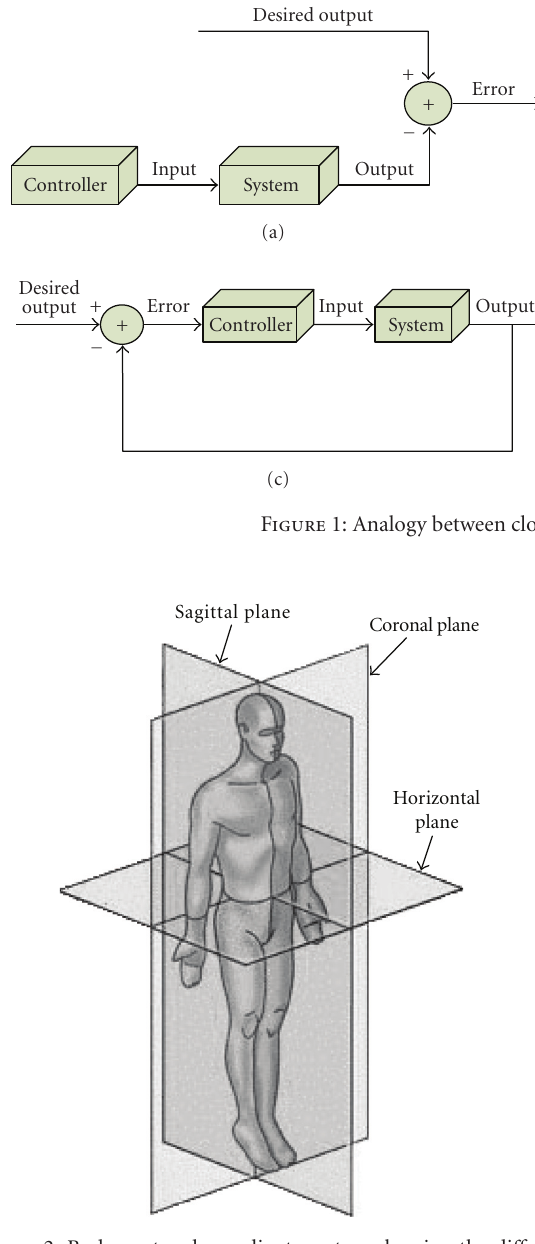
Figure 2: Body-centered coordinate system showing the di ff erent body